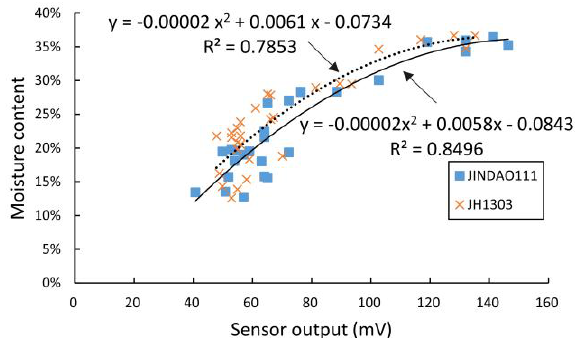
Figure 10. Output voltage of the sensor’s detector circuit versus absolute moisture of the corn under test.